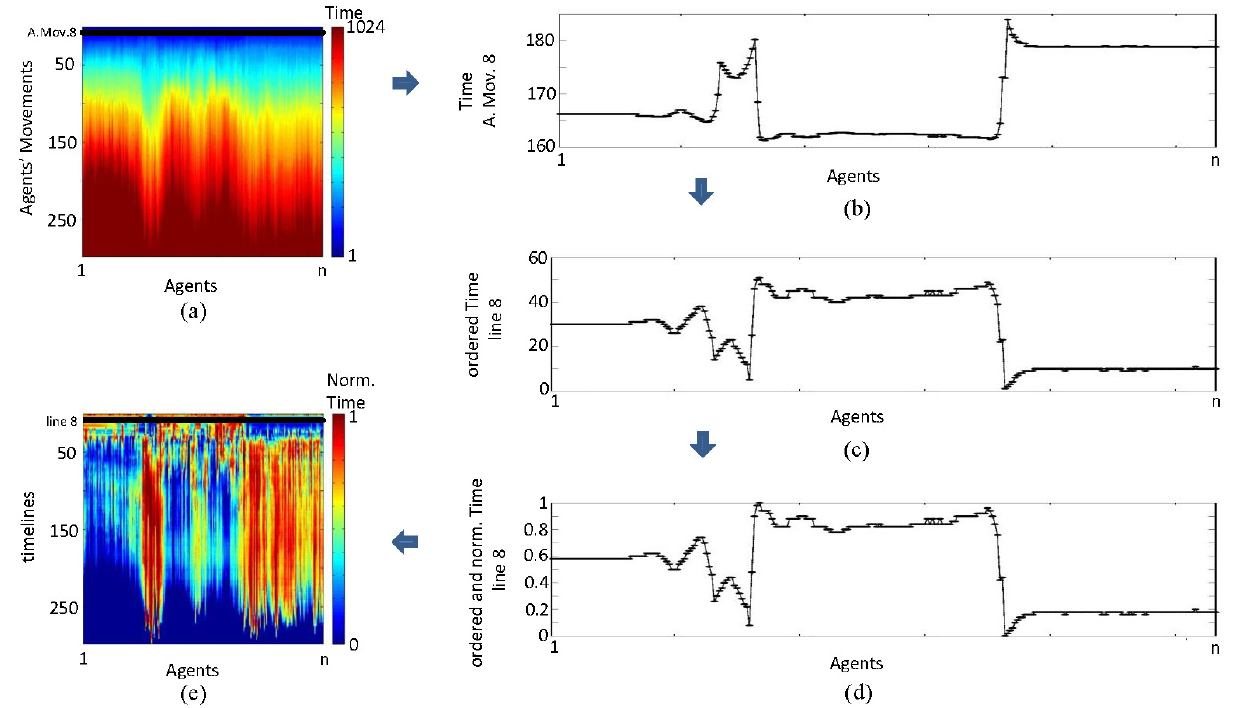
Figure 11. Output 2 building: ( a ) output 1; ( b ) time line; ( c ) ordered time line; ( d ) ordered and normalized time line; and ( e ) output 2.